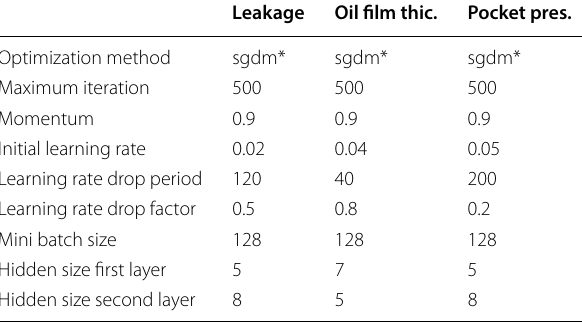
Table 2 Parameters of the proposed